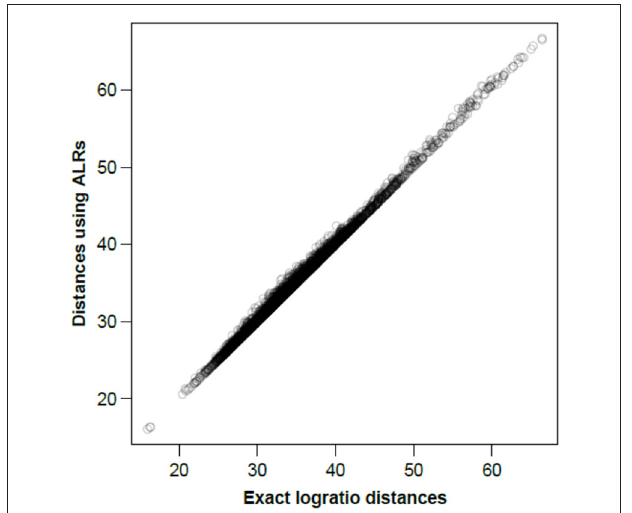
FIGURE 2 | Between-sample distances for the Rabbits dataset based on the ALRs with reference microbial gene 856 vs. the exact logratio distances, corresponding to the Procrustes correlation of 0.9991. The number of distances plotted 89 88 / 2 3,916. = × =